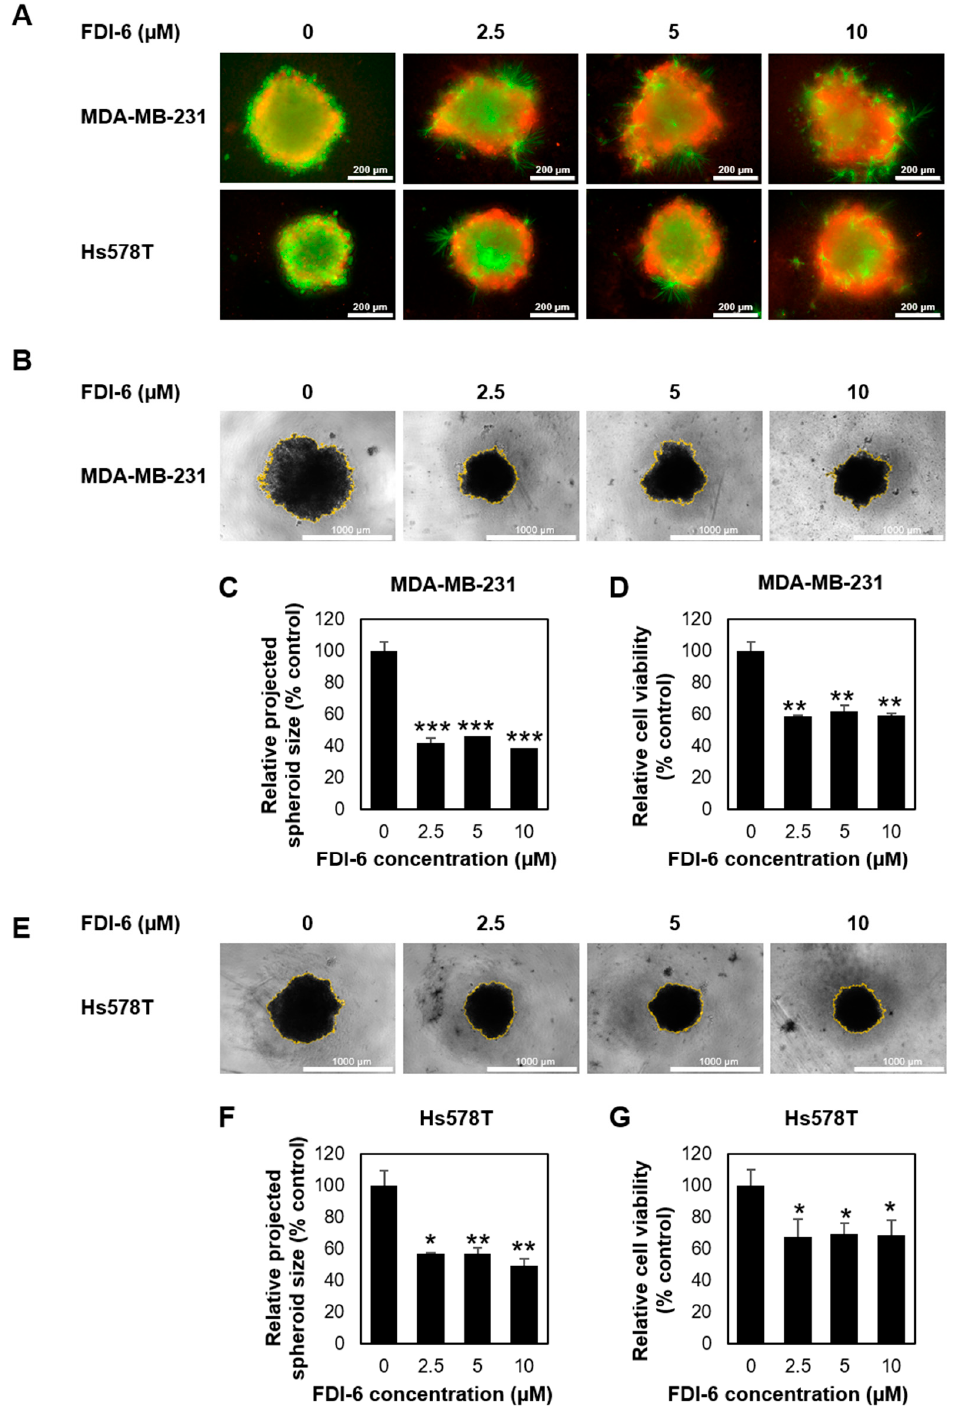
Figure 2. Effect of FDI-6 on the viability of the TNBC cells in 3D spheroid assays. ( A ) Live/dead staining (live = green and red = dead) of the MDA-MB-231 and Hs578T spheroids after being treated with different concentrations of FDI-6 for 72 h; ( B ) Representative images of the MDA-MB-231 spheroid size analysis after being treated with different concentrations of FDI-6 for 72 h and being incubated for a total of 21 days; ( C ) Relative size and ( D ) relative cell viability of FDI-6 treated MDA-MB-231 spheroids in comparison with the untreated spheroid; ( E ) Representative images of the Hs578T spheroid size analysis; ( F ) Relative size and ( G ) relative cell viability of the FDI-6 treated Hs578T spheroids in comparison with the untreated spheroid. All bar graphs represent an average of three independent experiments ± S.D. ( n = 3). Statistical significance was determined by Student’s t-test (significant, * p < 0.05, ** p < 0.01, *** p < 0.001).